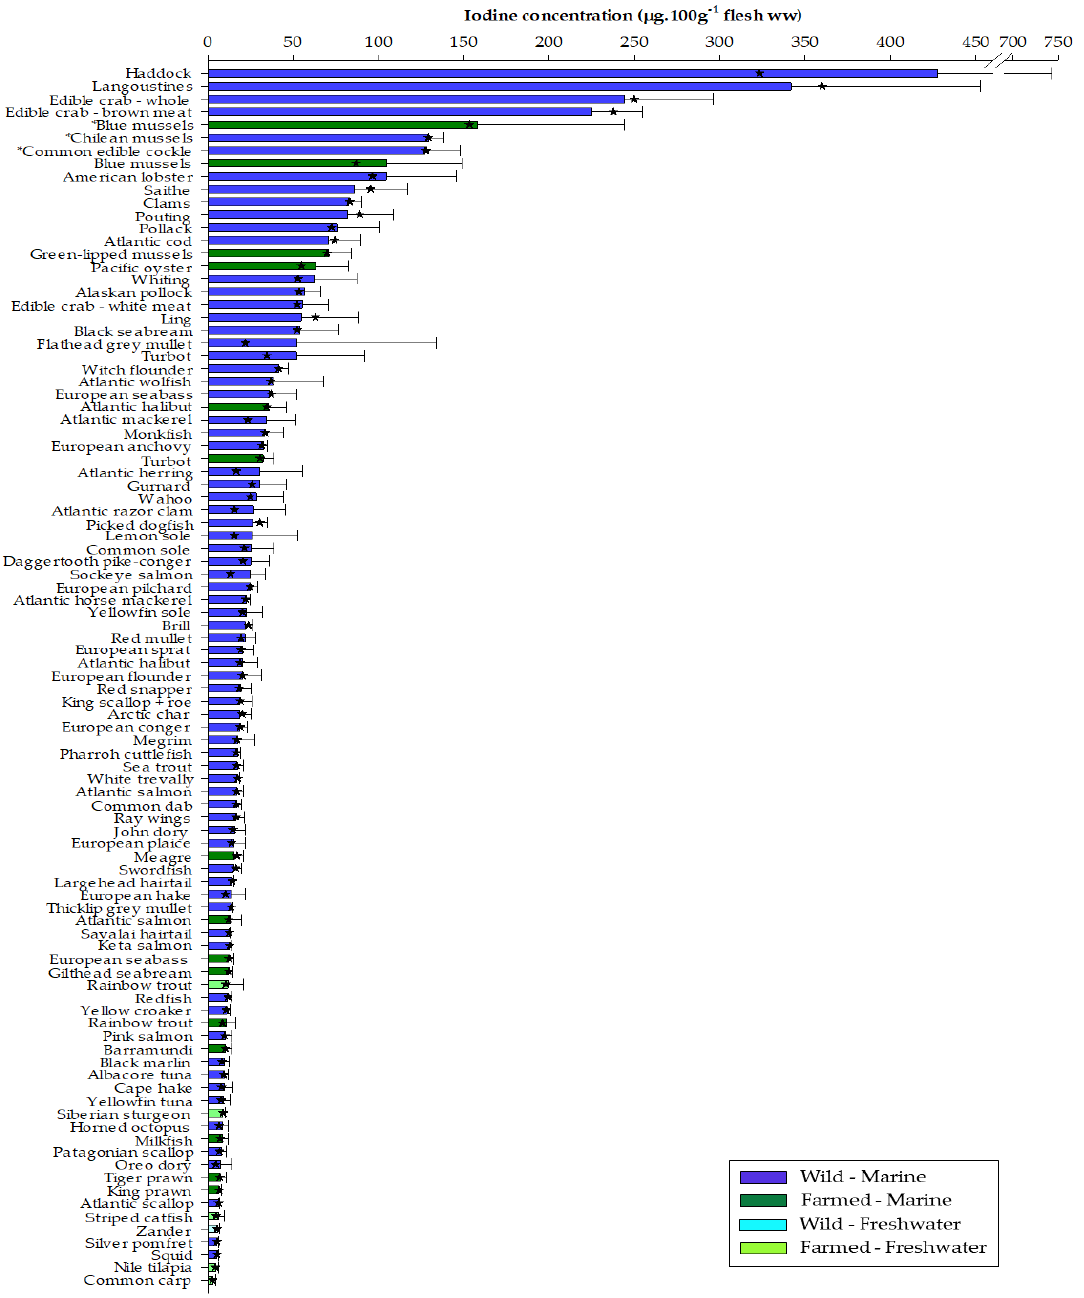
Figure 1. Iodine concentrations (µg·100 g −1 edible flesh, ww, mean ± SD) of 95 seafood samples of wild and or farmed marine or freshwater origin analysed in the current study. Samples ranked in descending order. (cid:70) indicates median iodine value. All samples were analysed raw unless denoted by *. Refer to Table 1 for further sample information.